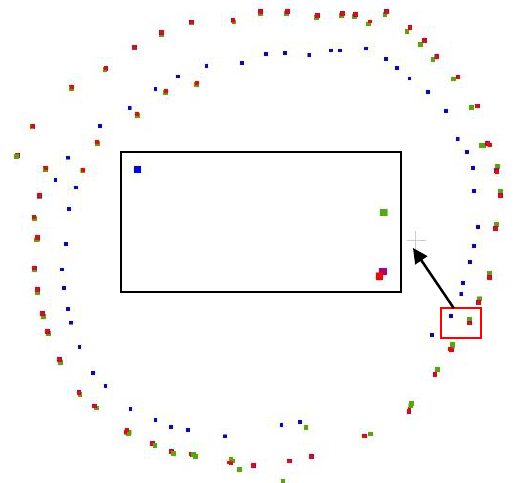
Figure 13. Visual analysis of the camera EO computed by using different software: PhotoModeler Scanner using only EXIF information (blue), PhotoModeler Scanner using calibrated camera (purple), Zephyr (red) and Visual SfM